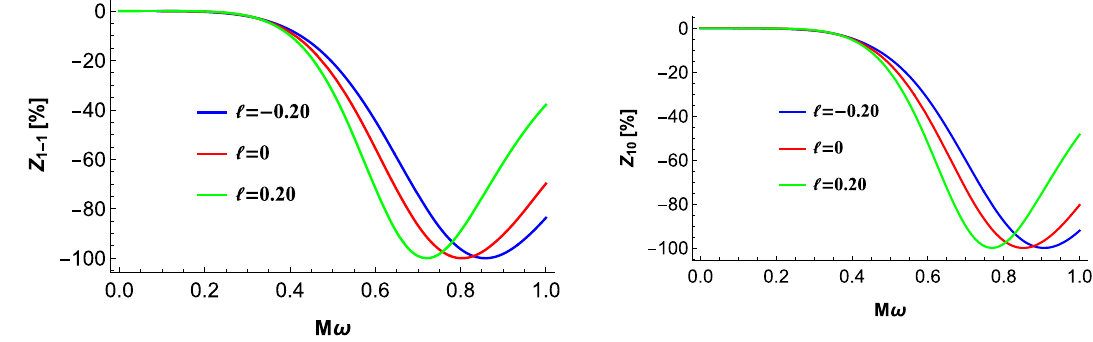
Fig. 5 Variation of amplification factors with (cid:2) for non-superradiant multipoles with ˆ μ = 0 . 1 , b = 0 . 01 M 2 , and ˆ a = 0 . 3 M